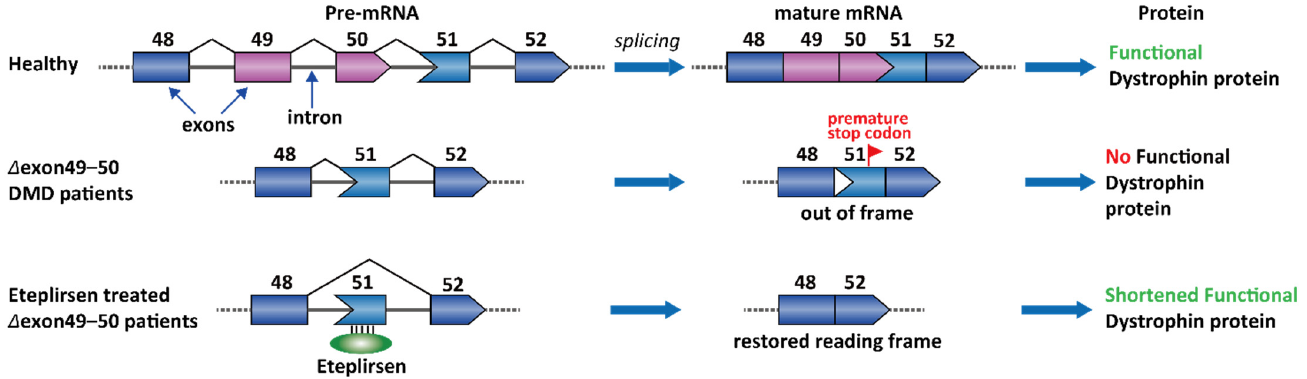
Figure 3. Therapeutic strategy of Eteplirsen for the treatment of DMD.